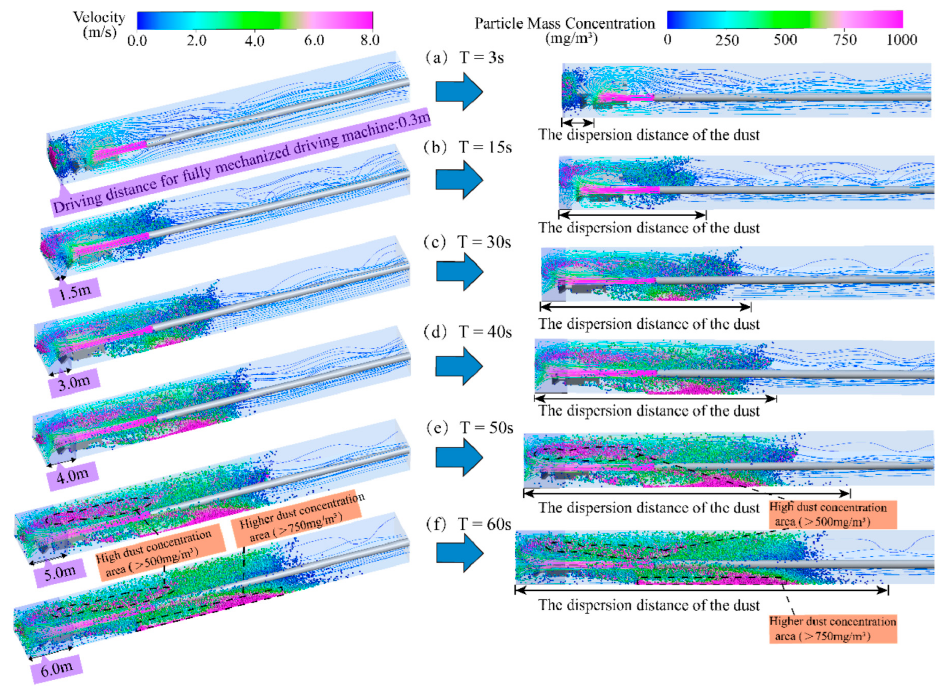
Figure 14. Dust distribution in tunneling at different diffusion times (Dynamic tunneling model).